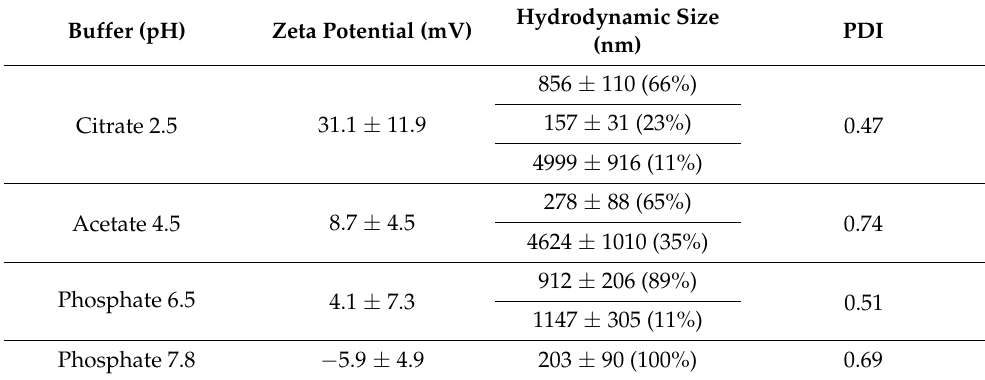
Table 4. JM72-bioparticle structural characteristics in different buffer solutions, all at 8